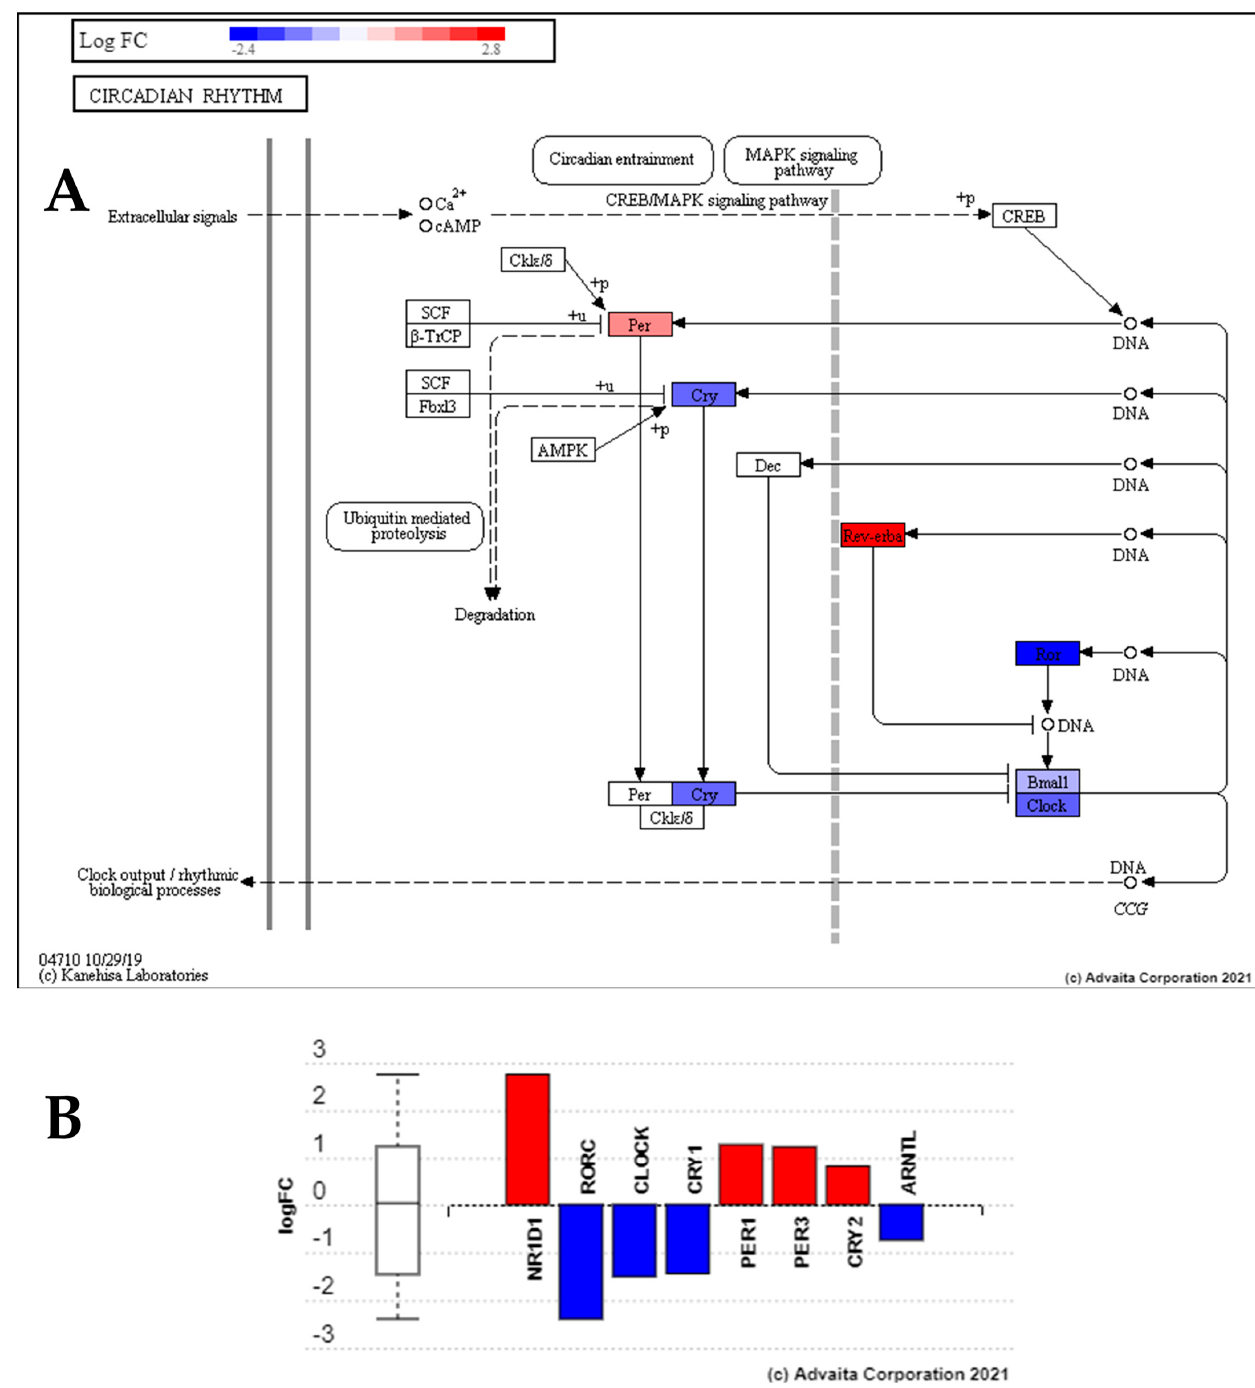
Figure 5. Perturbation of circadian rhythm pathway genes from exposure to low dose radiation compared to control group. This reveals upregulation of Per and Rev-Erba, and the downregulation of Cry, Clock, Bmal and Arntl in comparison to the control group (28.5-Ctrl), suggesting low dose radiation perturbs the circadian rhythm. ( A ) Pathway topological diagram showing position and regulation of differentially expressed circadian rhythm genes. RED: upregulated, BLUE: downregulated. ( B ) Bar chart showing fold change of differential expression of the key clock genes.